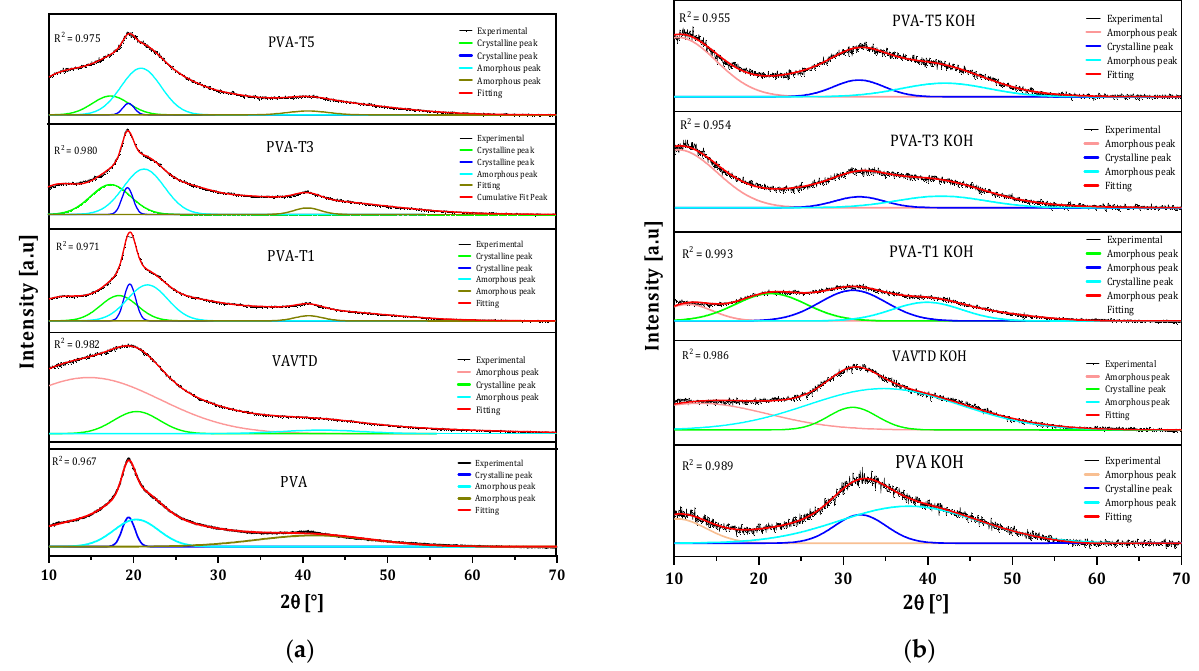
Figure 3. Comparison of the deconvoluted XRD patterns of ( a ) PVA-VAVTD and ( b ) PVA-VAVTD KOH systems at different VAVTD contents. Table 1. The Xc for each electrolyte calculated by the deconvoluted method.